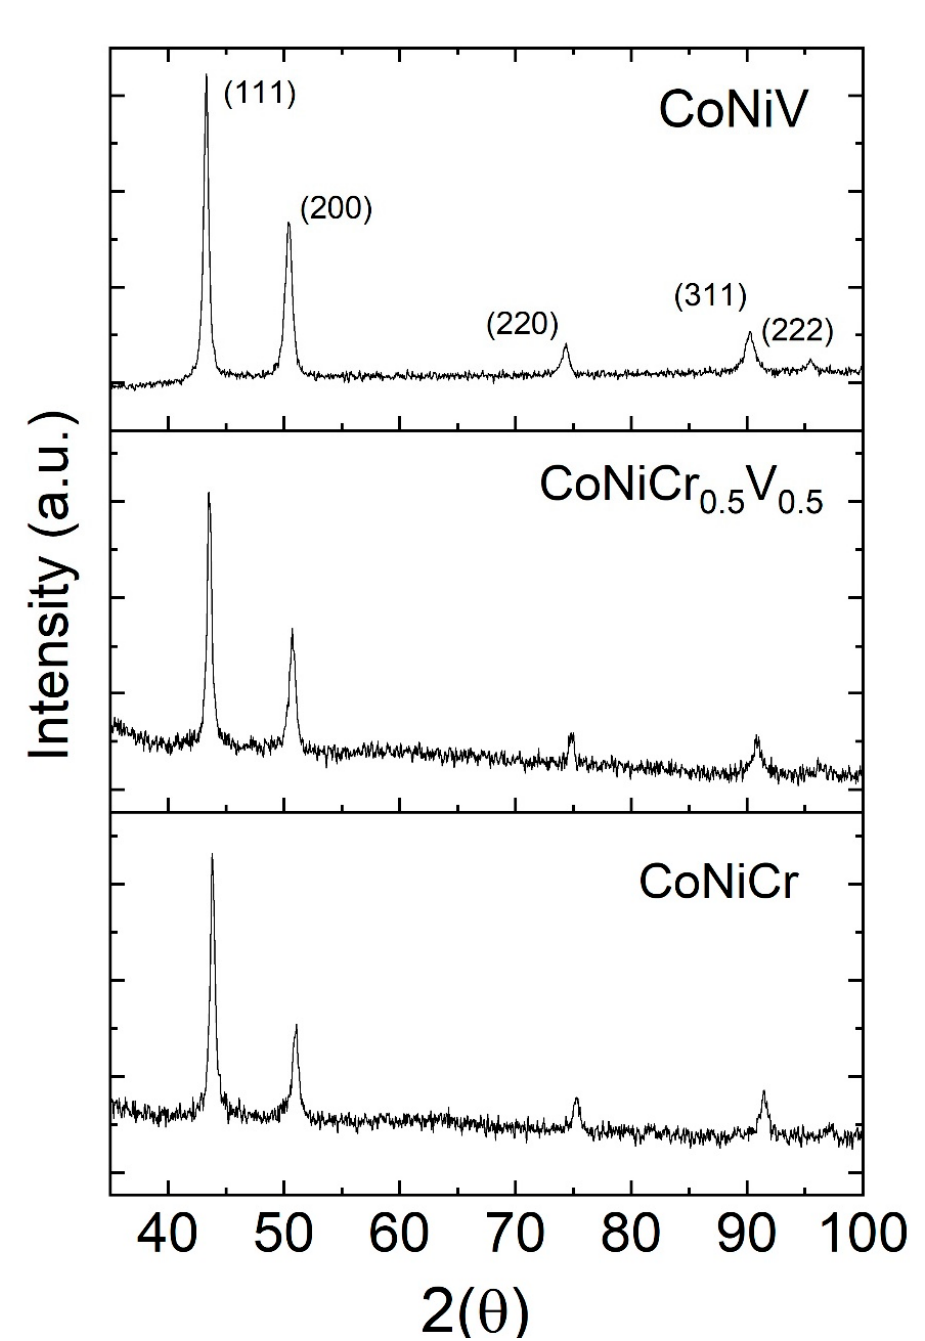
. V . and CoNiCr alloys. Figure 1. XRD graphs of the CoNiV, CoNiCr 0.5 V 0.5 , and CoNiCr alloys. 0 5 0 5,